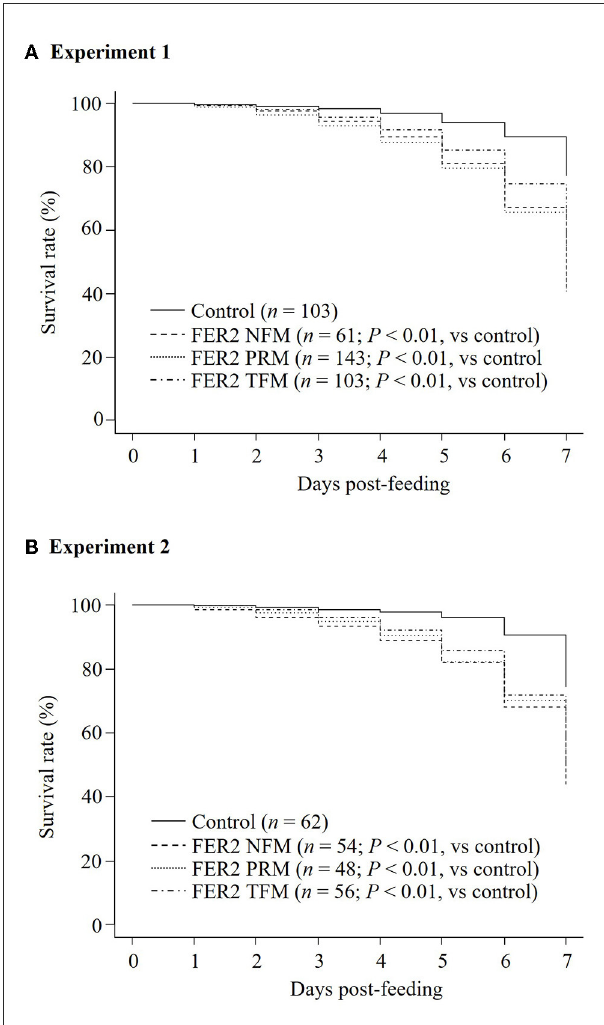
FIGURE5 Assessment of the acaricidal potential of plasma obtained from chickens immunized with recombinant ferritin 2 (rFER2) proteins. Artificial blood feeding to poultry red mite (PRMs) was performed by the in vitro feeding assay. The survival rates of PRMs fed with immune plasmas or control plasma were monitored daily for a week. The in vitro feeding assays were performed 2 times. The total number of PRMs used in this study is as follows: (A) experiment 1: fed with immune plasma: n = 143 (rFER2 PRM), n = 103 [rFER2 tropical fowl mite (TFM)], and n = 61 [rFER2 northern fowl mite (NFM)] and fed with control plasma: n = 103; (B) experiment 2: fed with immune plasma: n = 48 (rFER2 PRM), n = 56 (rFER2 TFM), and n = 54 (rFER2 NFM) and fed with control plasma: n = 62. The number of dead PRMs were recorded and plotted on the graph to generate Kaplan–Meier survival curves. Statistical analysis was performed using a log-rank test with Bonferroni corrections on multiple comparisons. P < 0.01 was considered statistically significant between each immunized and control